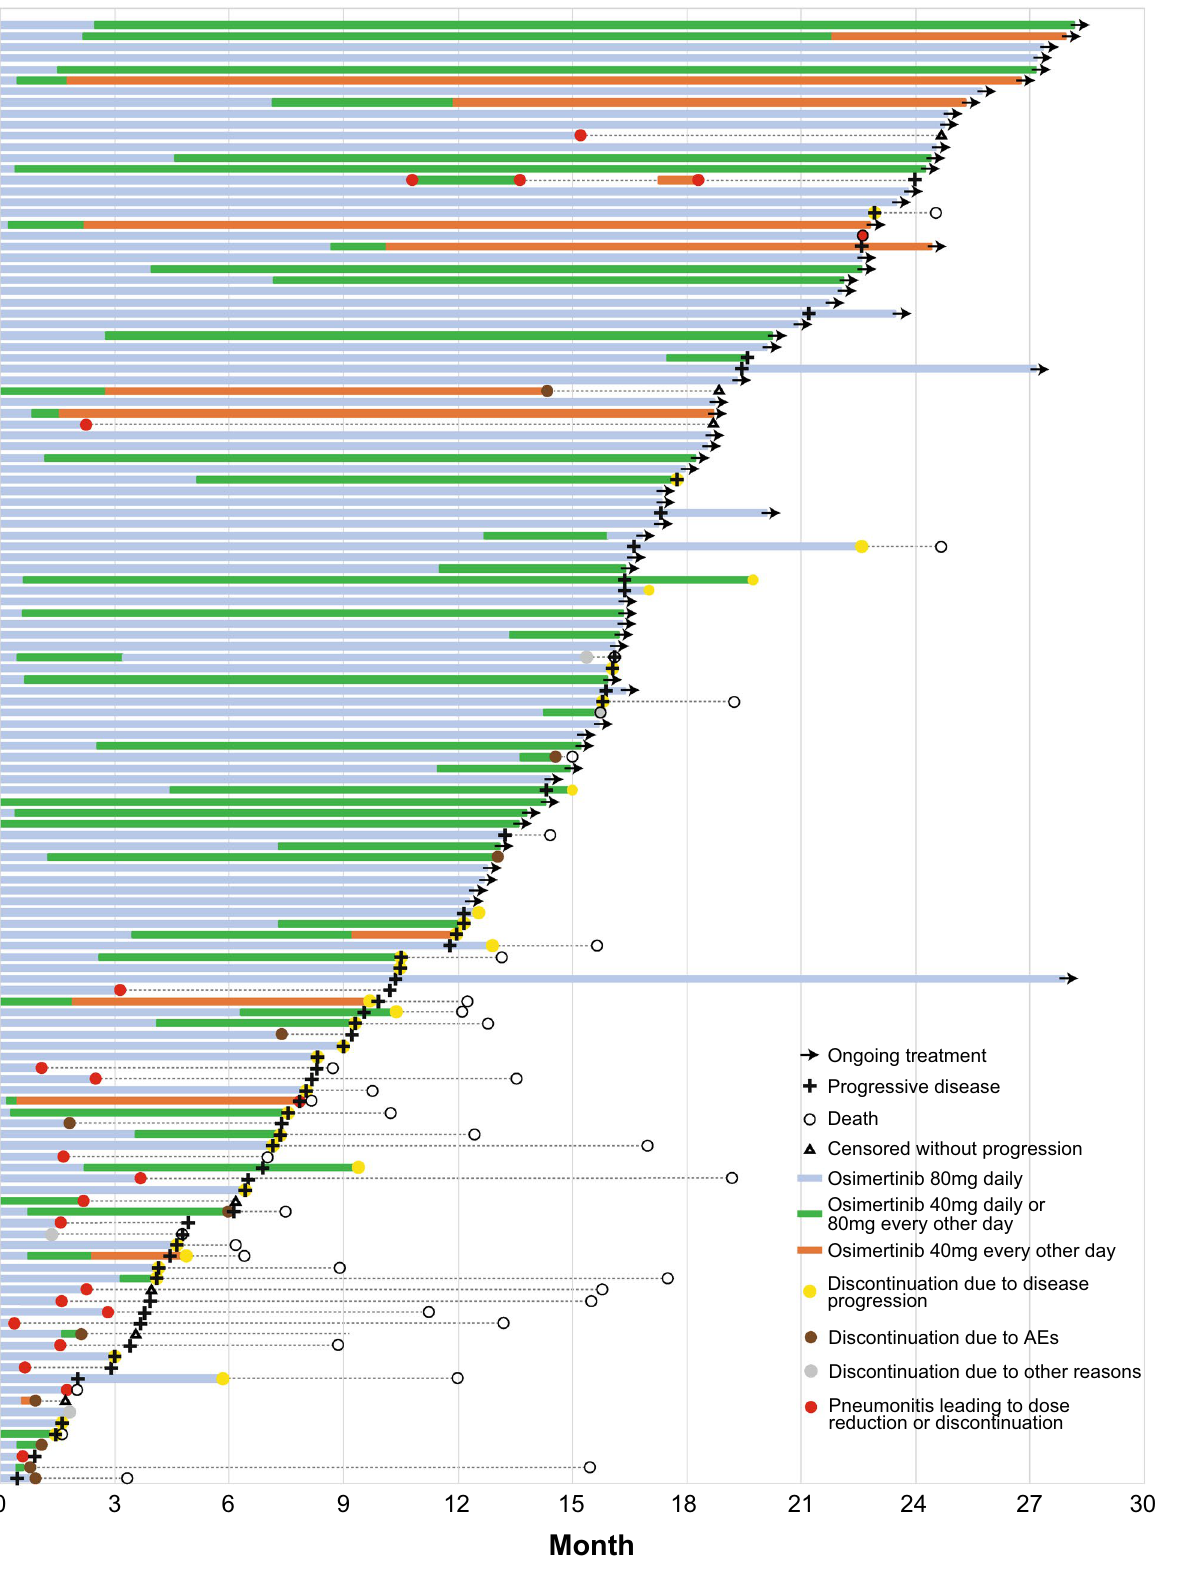
Figure 3. Swimmer plot for progression-free survival, overall survival, treatment duration, osimertinib dose, and reasons leading to treatment discontinuation in all patients (n = 132). AEs adverse